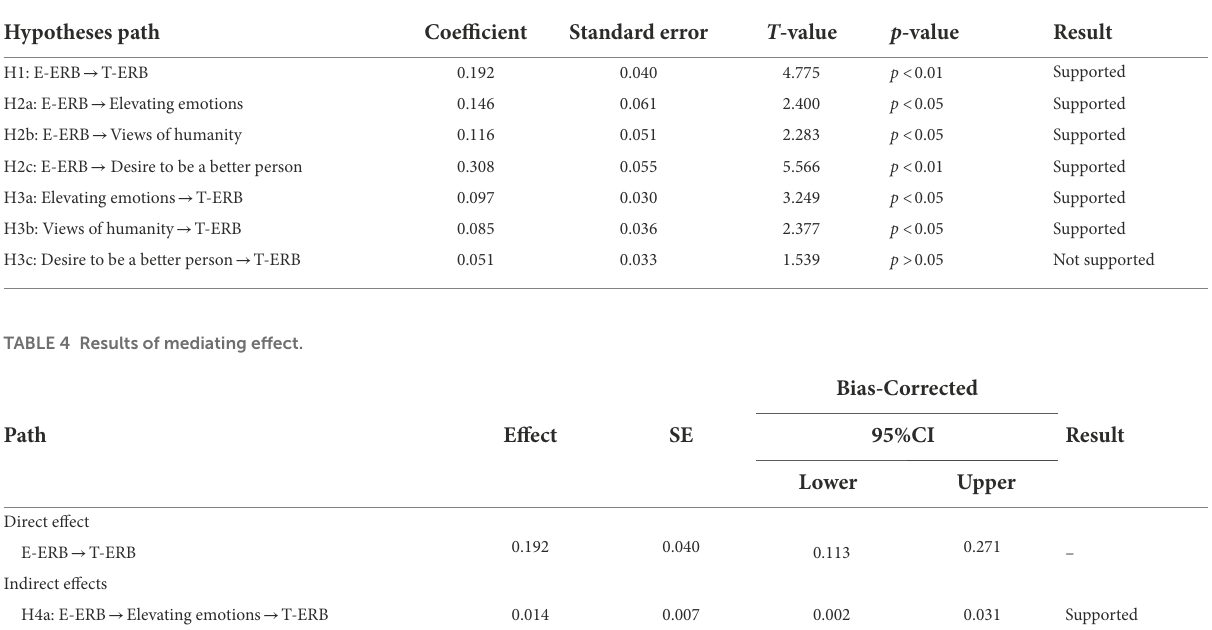
TABLE 3 Results of hypotheses.